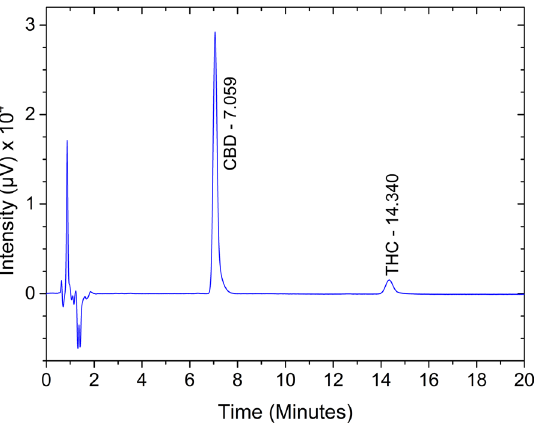
Figure 2. System suitability chromatogram of CBD and THC standard mixture (10 µg/mL CBD and 1 µg/mL THC) for assay.